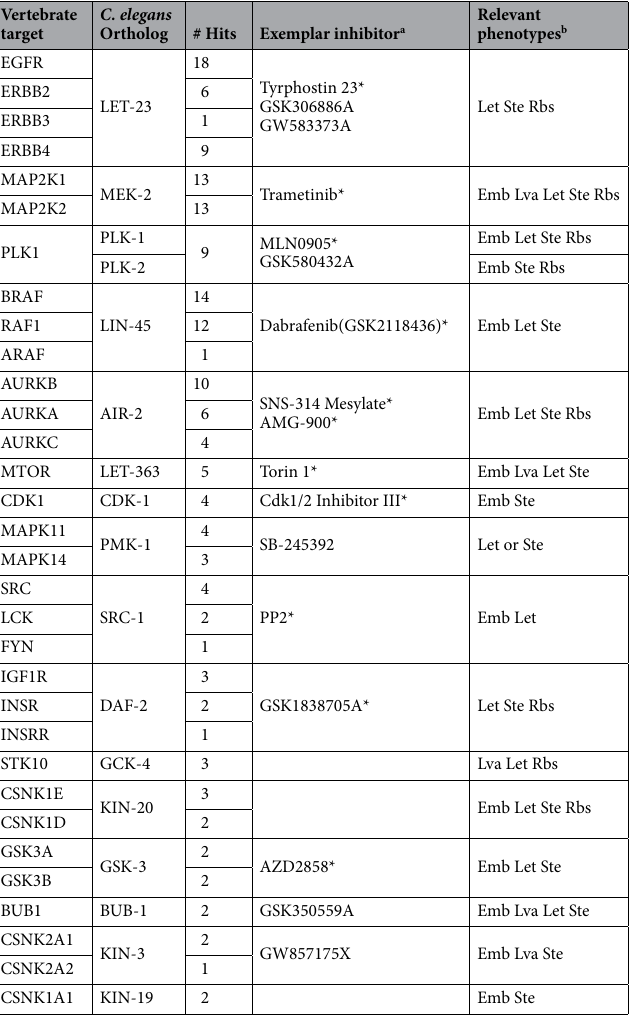
Table 1. Druggable essential nematode kinase targets. a Commercially available inhibitors indicated with an asterisk (*). b Embryonic Lethal (Emb); Larval Arrest (Lva); Lethal (Let); Sterile (Ste); Reduced Brood Size